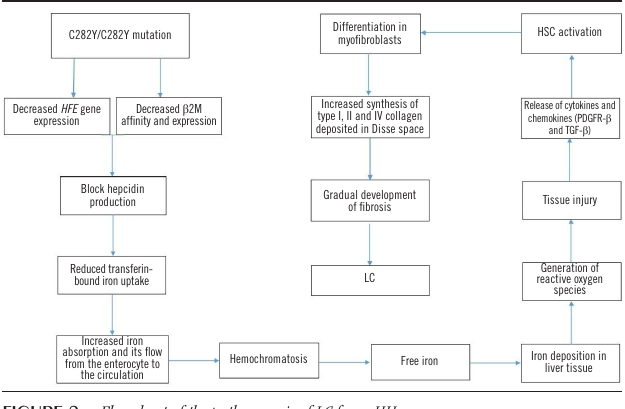
FIGURE 2 – Flowchart of the pathogenesis of LC from HH LC: liver cirrhosis; HH: hereditary hemochromatosis; β 2M: β 2-microglobulin; HSC: hepatic stellate cells; PDGFR- β : platelet-derived growth factor receptor beta; TGF- β : transforming growth factor